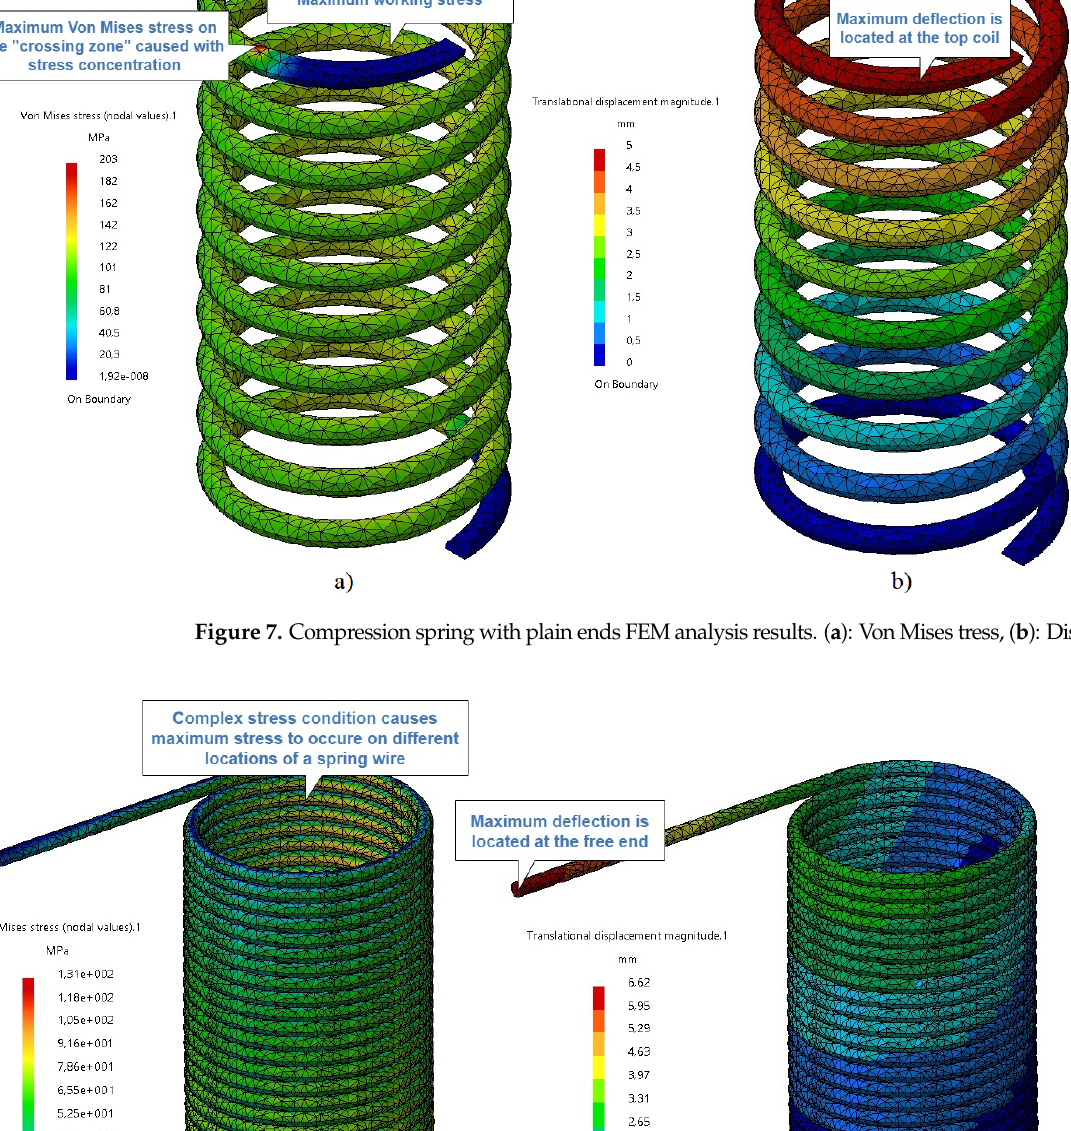
Table 2. Number of finite elements and nodes for specific spring design.